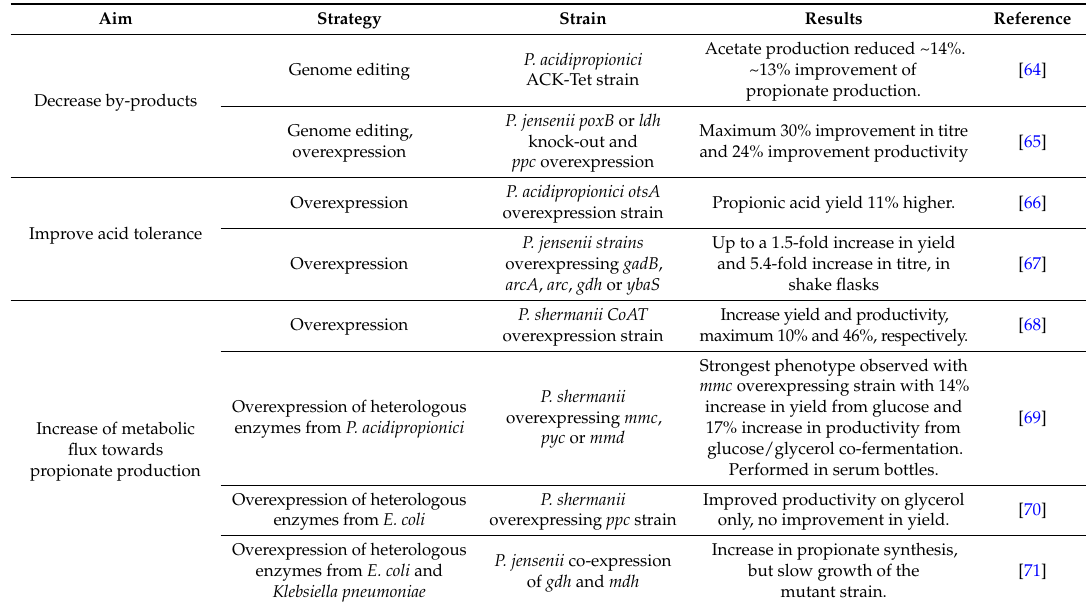
Table 9. Geneticengineeringstrategiesperformedinpropionibacteriatoimprovepropionicacidproduction 1 . Aim Strategy Strain Results Reference Genome Decrease by-products